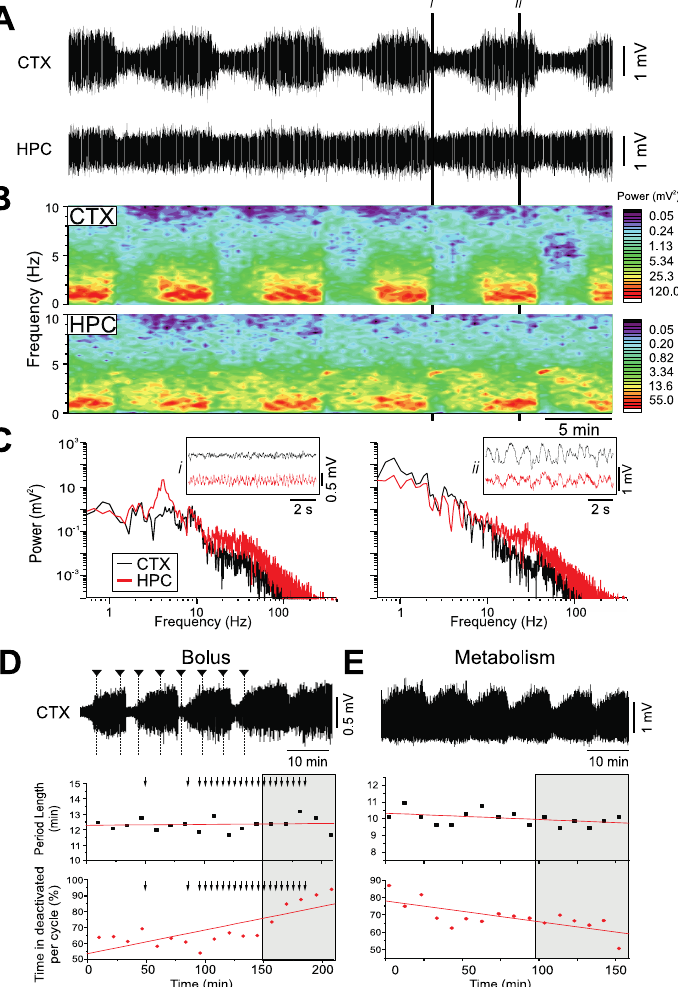
Figure 1. Spontaneous and cyclic alternations of brain state under urethane anesthesia. ( A ): Continuous, 40 min duration cortical (CTX) and hippocampal (HPC) EEG traces. 10 s samples of activated (i) and deactivated (ii) states are expanded in C. ( B ): Spectrograms of CTX (top) and HPC (bottom) EEG traces in A. ( C ): Power spectra for the CTX and HPC during an activated state (left), and a deactivated state (right), with insets of 10 s raw traces representative of each state. ( D ): 60 min cortical EEG sample (top). Arrows indicate administration of supplemental doses of urethane in increments of 0.01 mL. The sample trace is denoted by the grey box in both the scatterplots of the period length of cycles across time (linear fit, n = 17, p = 0.74) and the percentage of time spent in deactivated per cycle (linear fit, n = 17, p < 0.01). ( E ): 60 min cortical EEG sample (top) of metabolism of urethane over time. The sample trace is denoted by the grey box in both the scatterplots of the period length of cycles across time (linear fit, n = 16, p = 0.11) and the percentage of time spent in deactivated per cycle (linear fit, n = 16, p < 0.01).